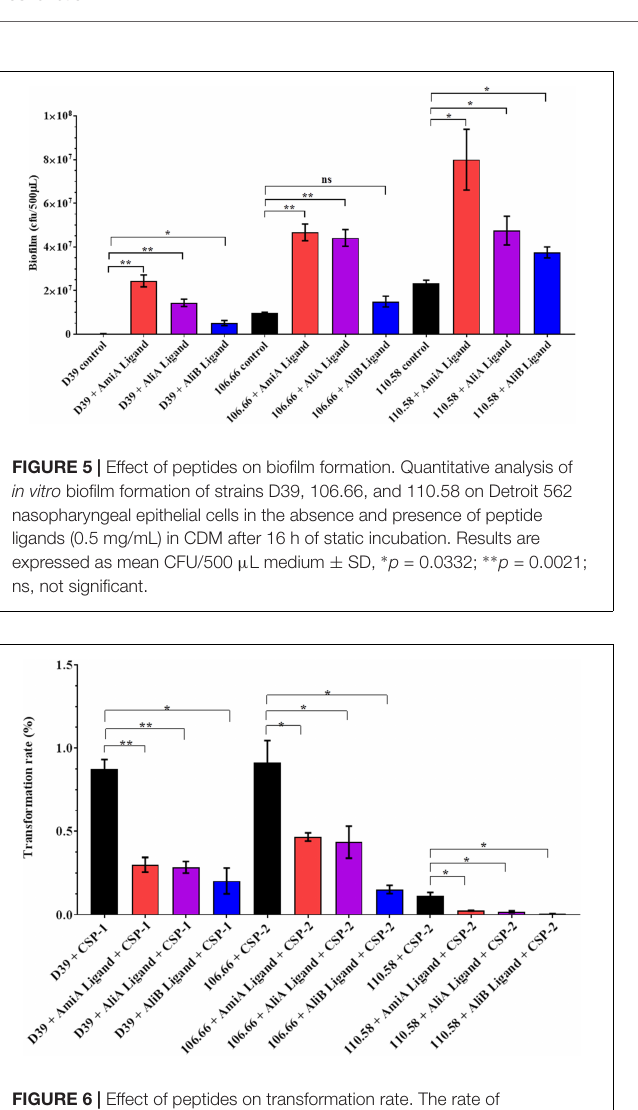
FIGURE 6 | Effect of peptides on transformation rate. The rate of transformation to antibiotic resistance by the uptake of DNA from a resistant strain was determined for strains D39, 106.66, and 110.58 in the presence of the appropriate CSP (as indicated on the x -axis) and the absence and presence of the peptide ligands (0.5 mg/mL). Percentage transformation rates are the means ± SD of three independent experiments, ∗ p = 0.0332; ∗∗ p = 0.0021; ns, not